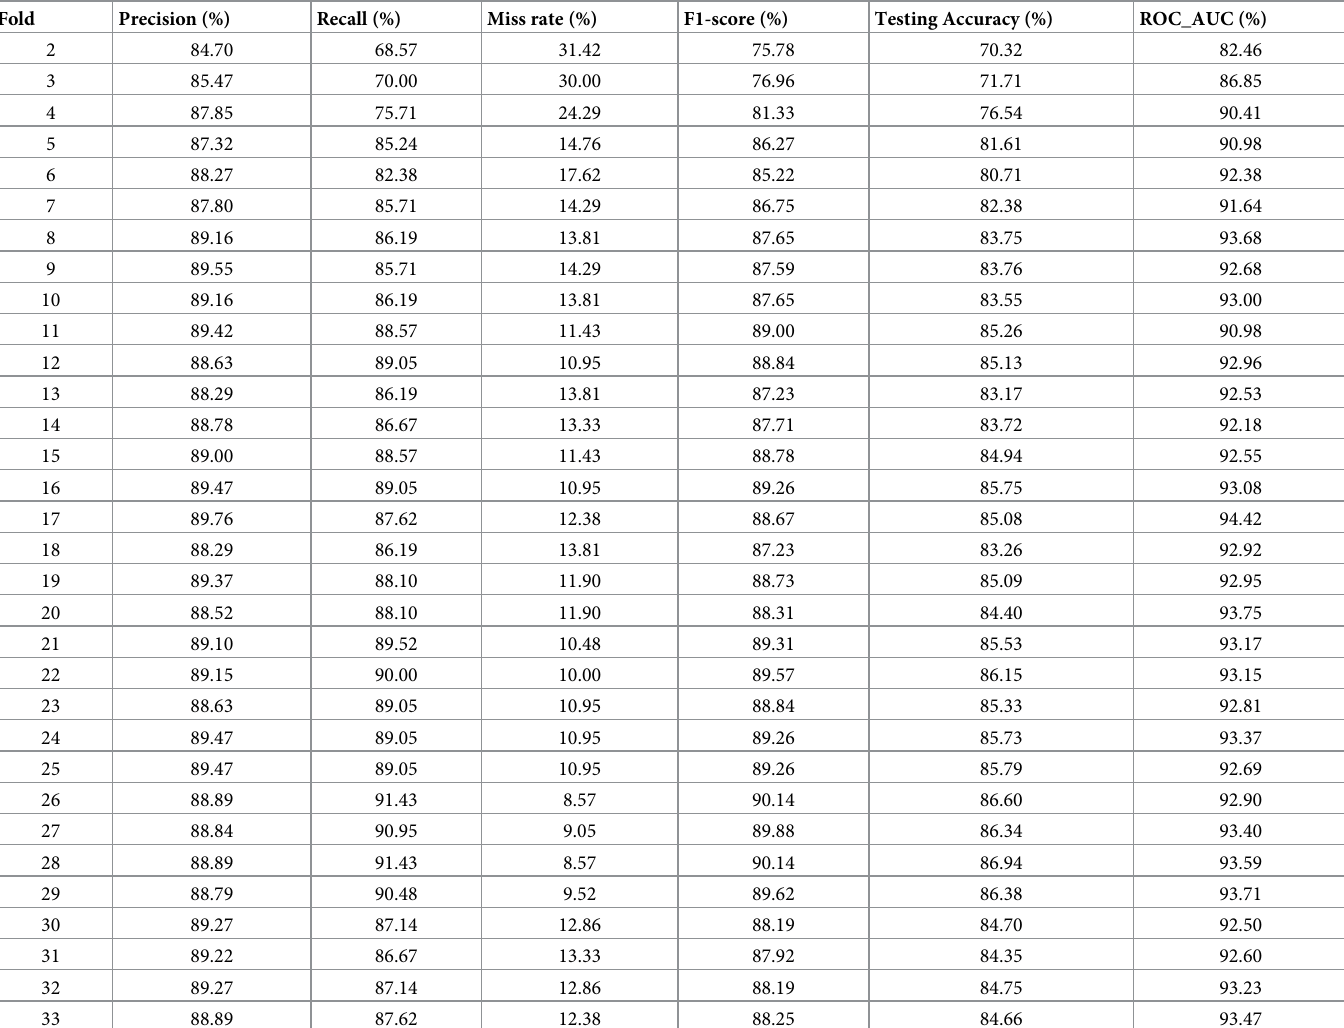
Table 14. Performance results of bagging SVM using cross